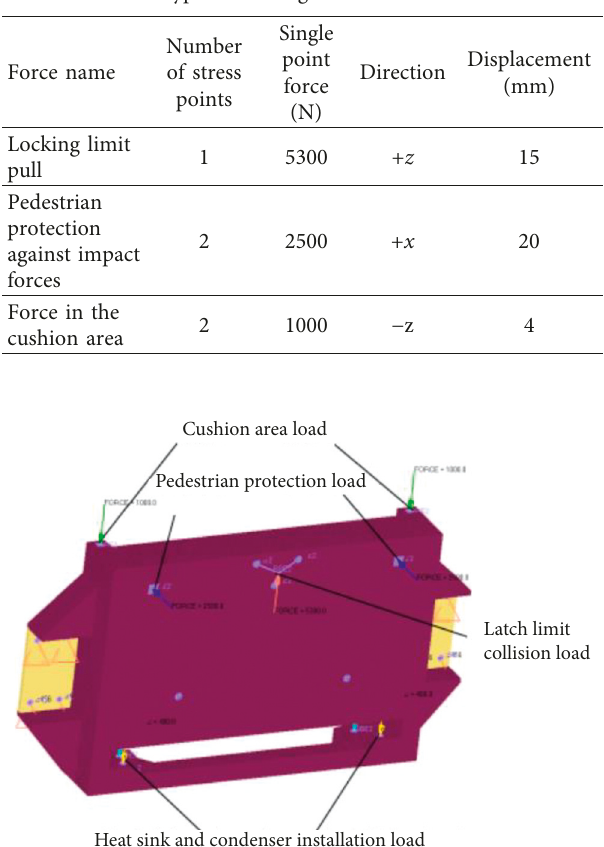
Table 1: Typical working conditions of the force.